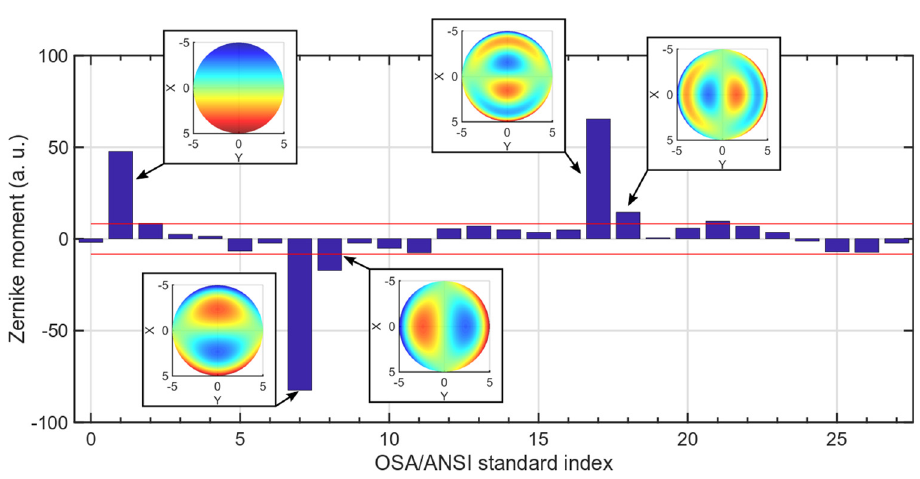
Figure A1. A Zernike decomposition of the operating deflection shape shown in Figure 3(C)c. The dominating mode carries index